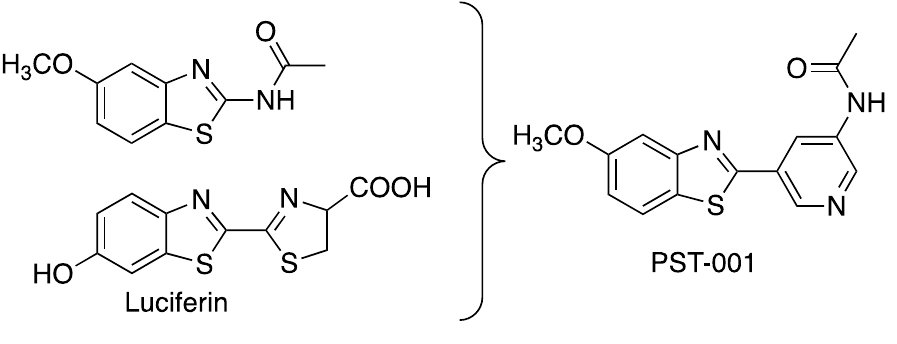
Figure 1. The design of PST-001.